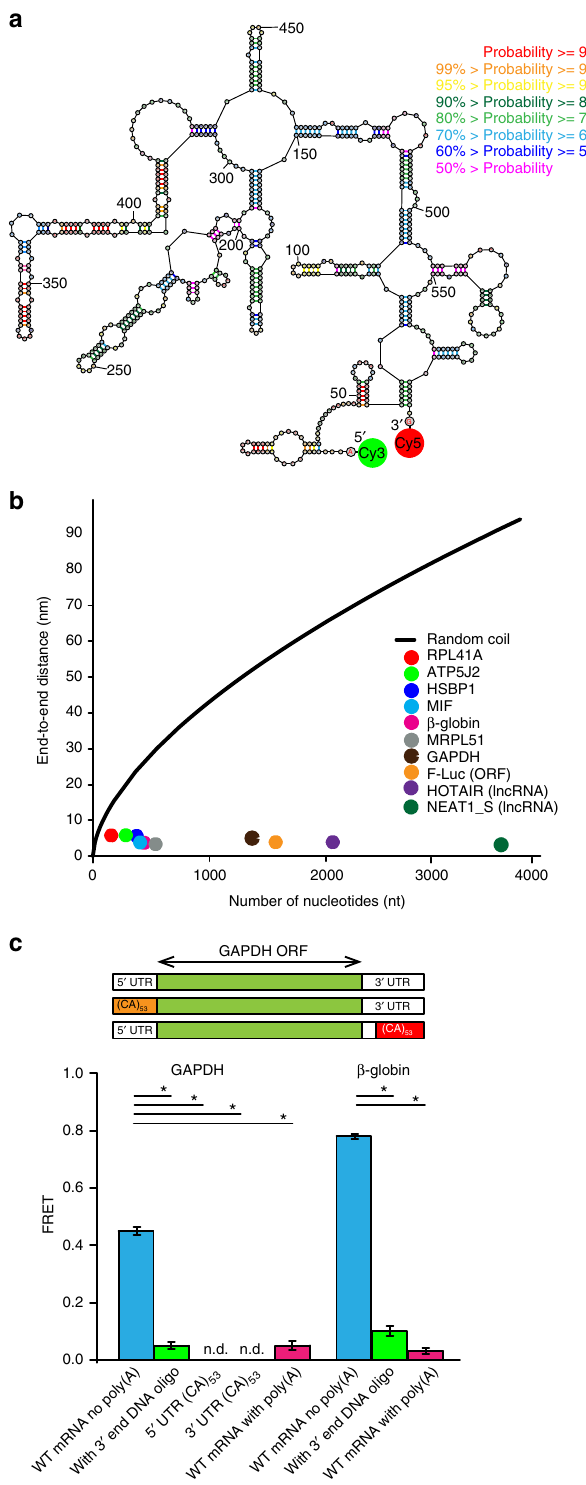
test this prediction, we examined end-to-end distance in indivi- dual GAPDH, β -globin, and MIF mRNA molecules by measuring smFRET using total internal re fl ection fl uorescence (TIRF) microscopy. smFRET reveals the structural dynamics of indivi- dual molecules that are masked in ensemble (bulk) FRET mea- surements because of signal averaging in the heterogeneous and non-synchronized population 13 . A previous smFRET study,